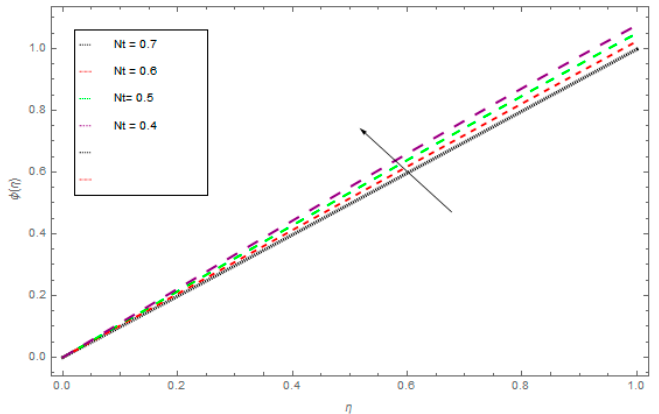
Figure 9. The influence of Nt on φ ( η ) when Nb = 0.6, Sc = 0.7, S = 0.7.